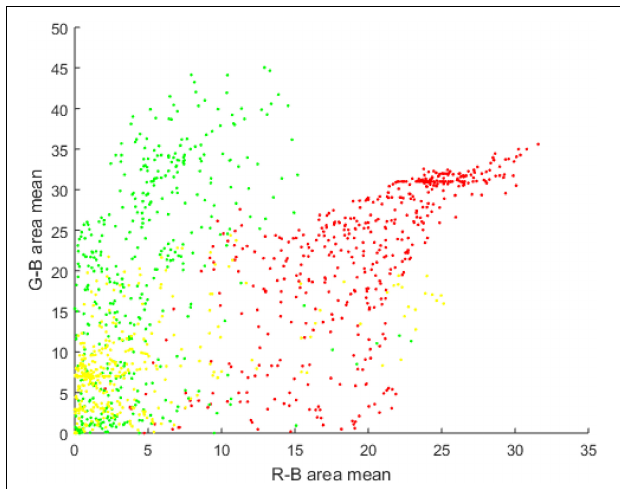
FIGURE 8 | The feature space of the mean value of R-B and G-B.